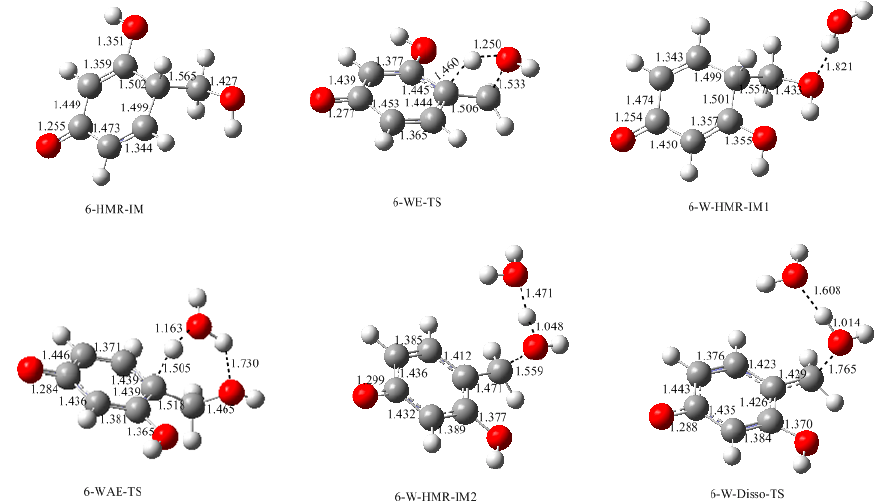
Figure 6. The calculated structures of the intermediates and transition states for the formation of 6-QM (quinonemethide) via the WE (water elimination) and WAE (water-aided elimination) mechanisms.